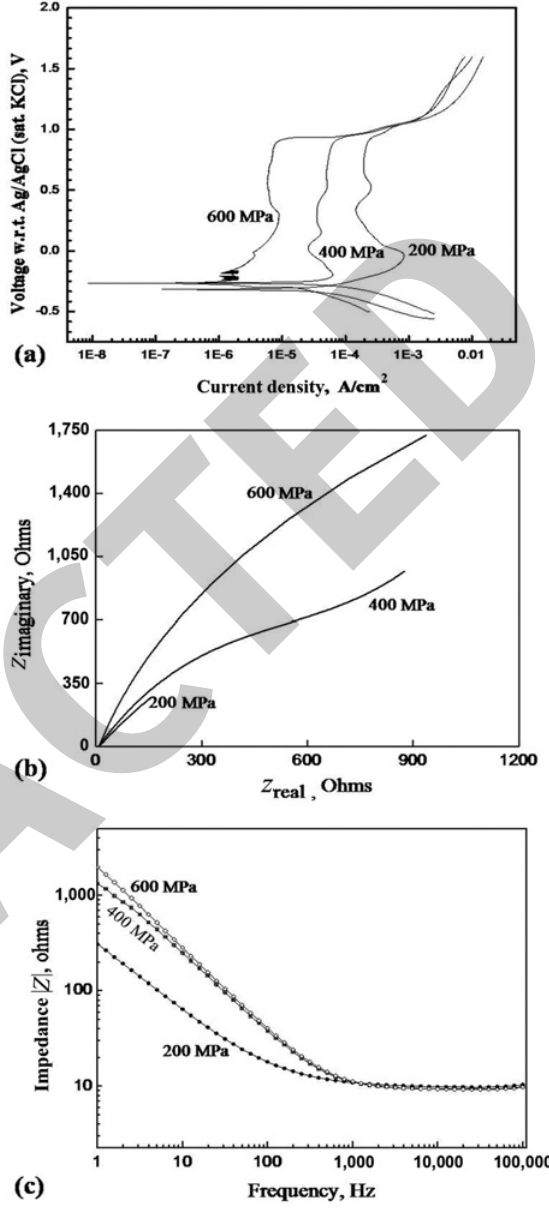
Figure 6: (a) Potentiodynamic polarization curves, (b) Nyquist plot and (c) Bode plot for 316L compacted at different pressures (200, 400 and 600 MPa) and sintered at